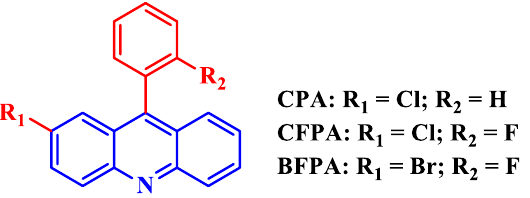
Figure 2. Molecular structures of halogen-substituted 9-phenyl acridines.